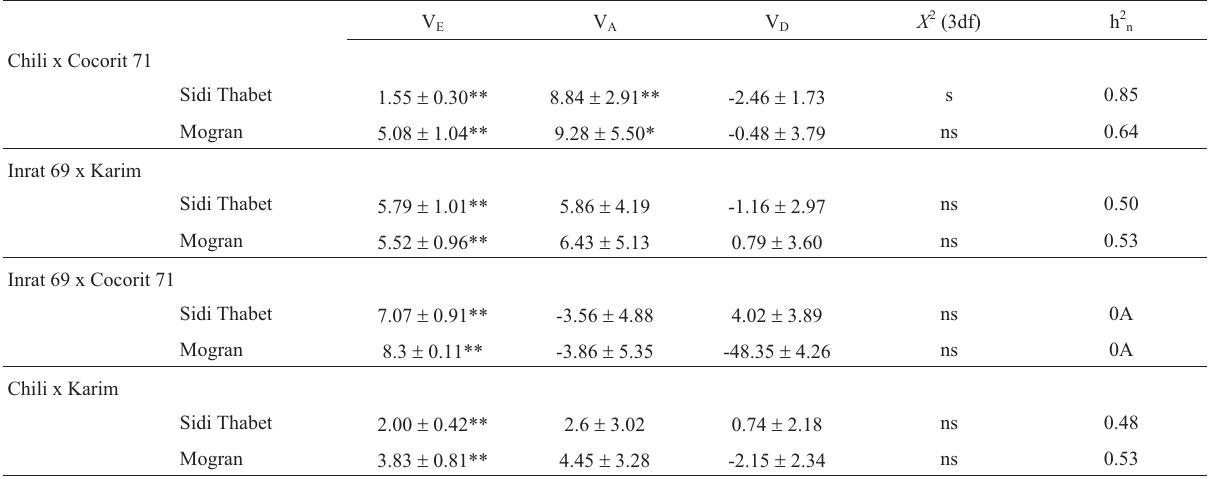
n )infourcrossesattwosites(MogranandSidiThabet),withtworepli-